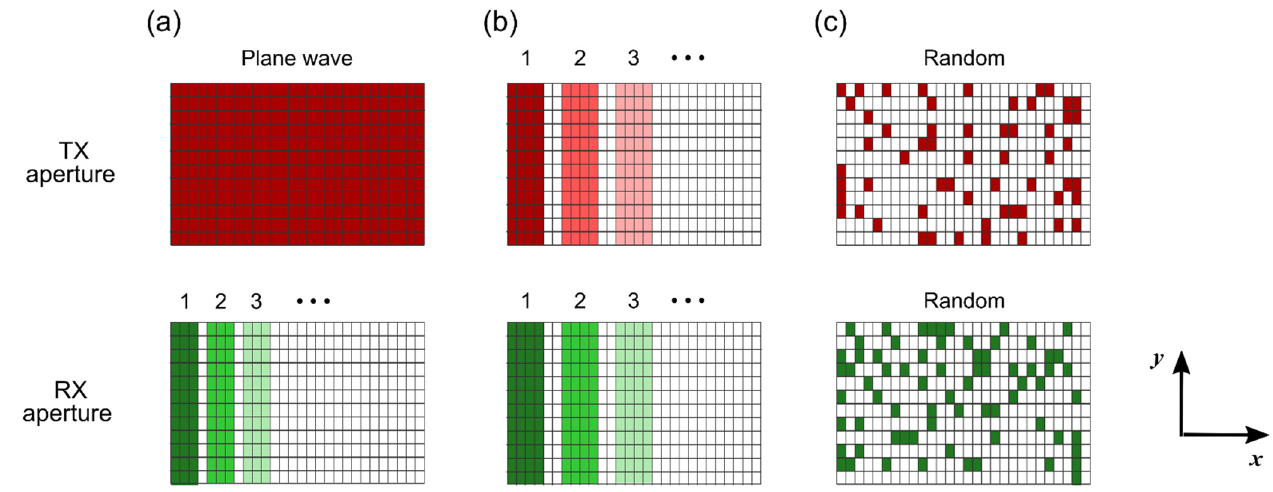
Figure 2. Example imaging schemes determined by different transmit and receive element configura- tions. ( a ) Plane-wave imaging. ( b ) Dynamic linear array. ( c ) Random pattern imaging.